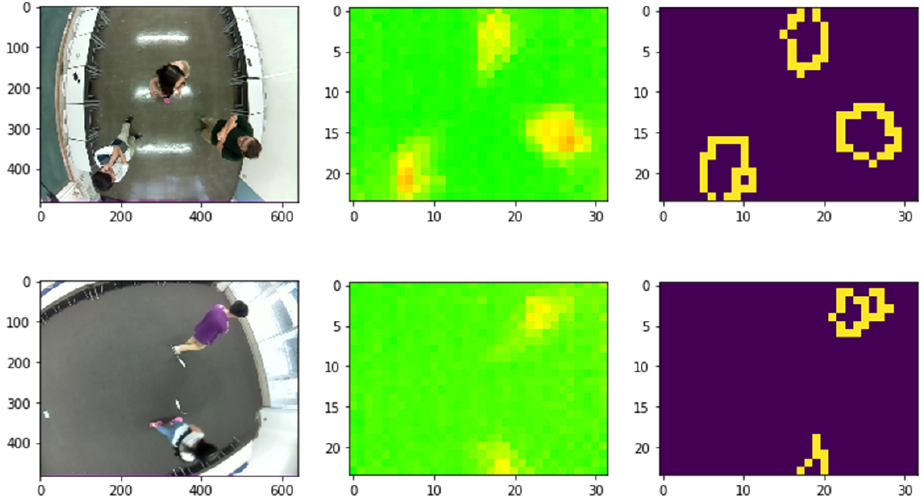
Figure 9. Examples of the same instant as captured by the camera ( left ), the sensor ( middle ) and processed sensor frames to identify the location of detected people ( right